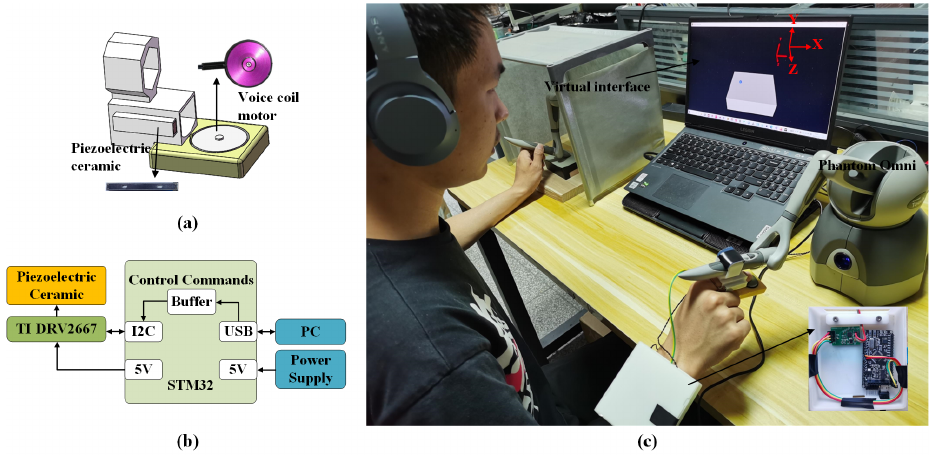
Figure 13. ( a ) The schematic diagram of the fingertip device. ( b ) The block diagram of the piezoelectric ceramic control module. ( c ) Haptic rendering interface. The participant used Omni with the attached fingertip device to feel the virtual sample and another Omni handle to feel the real